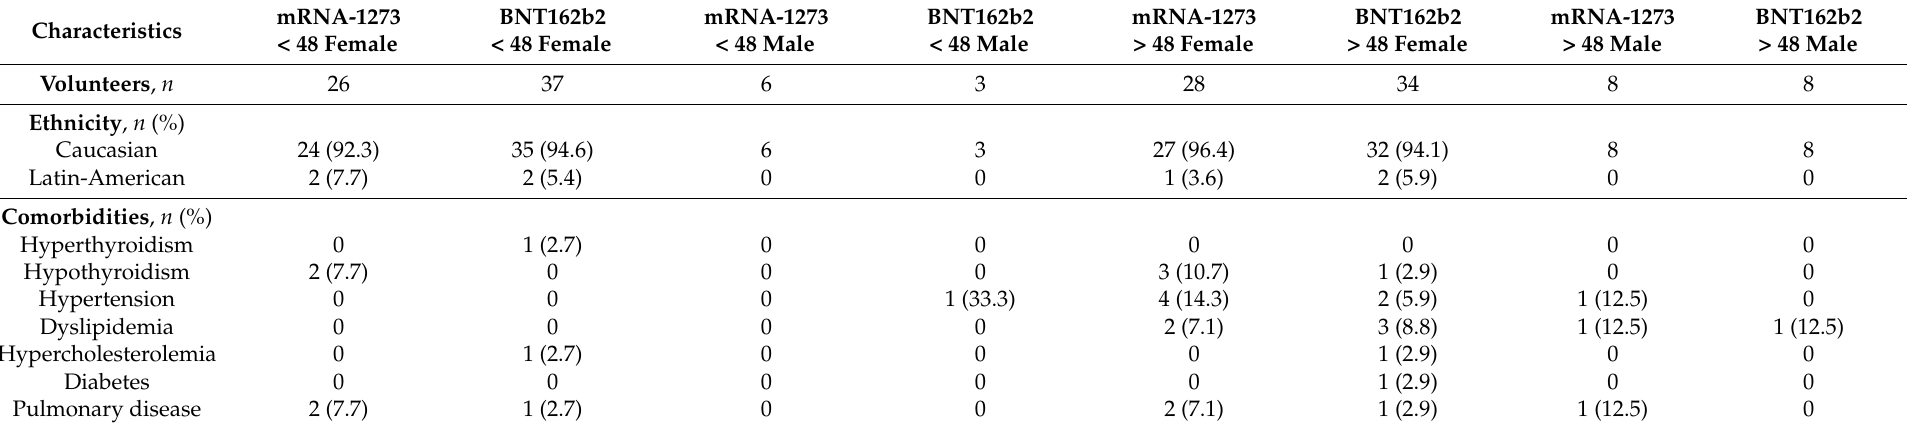
Table 2. Characteristics of the vaccinated cohort, stratified by age and gender.